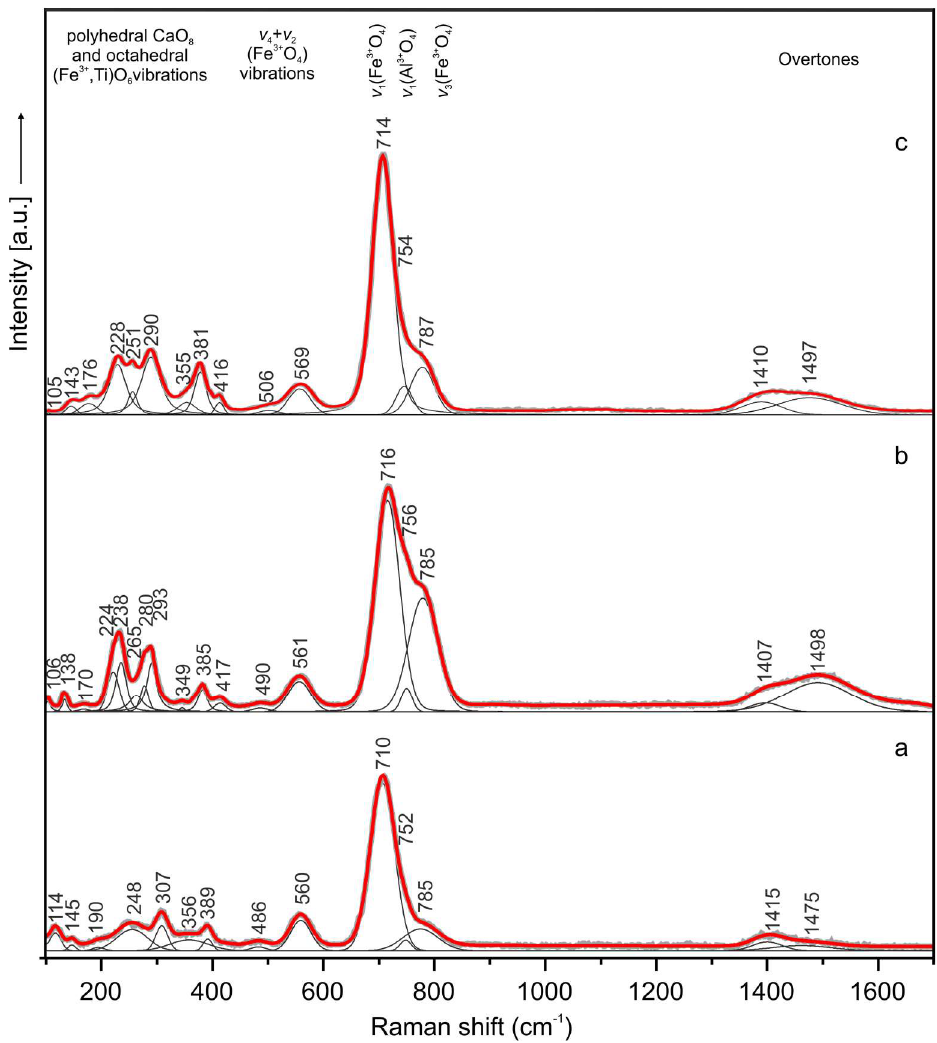
Figure 9. Raman spectra of sharyginite from the Bellerberg volcano ( a ), Jabel Harmun ( b ) and Upper Chegem Volcanic Caldera ( c ) localities.